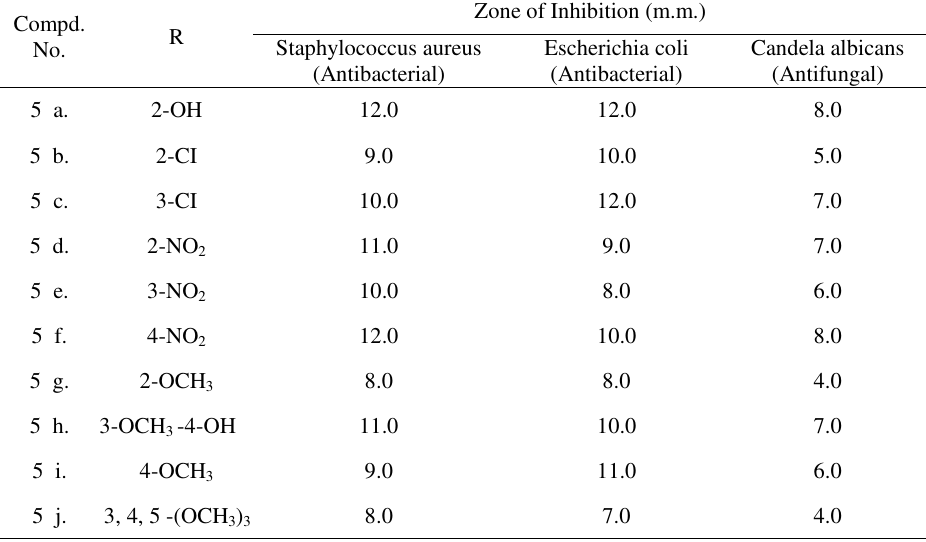
Zone of Inhibition (m.m.)